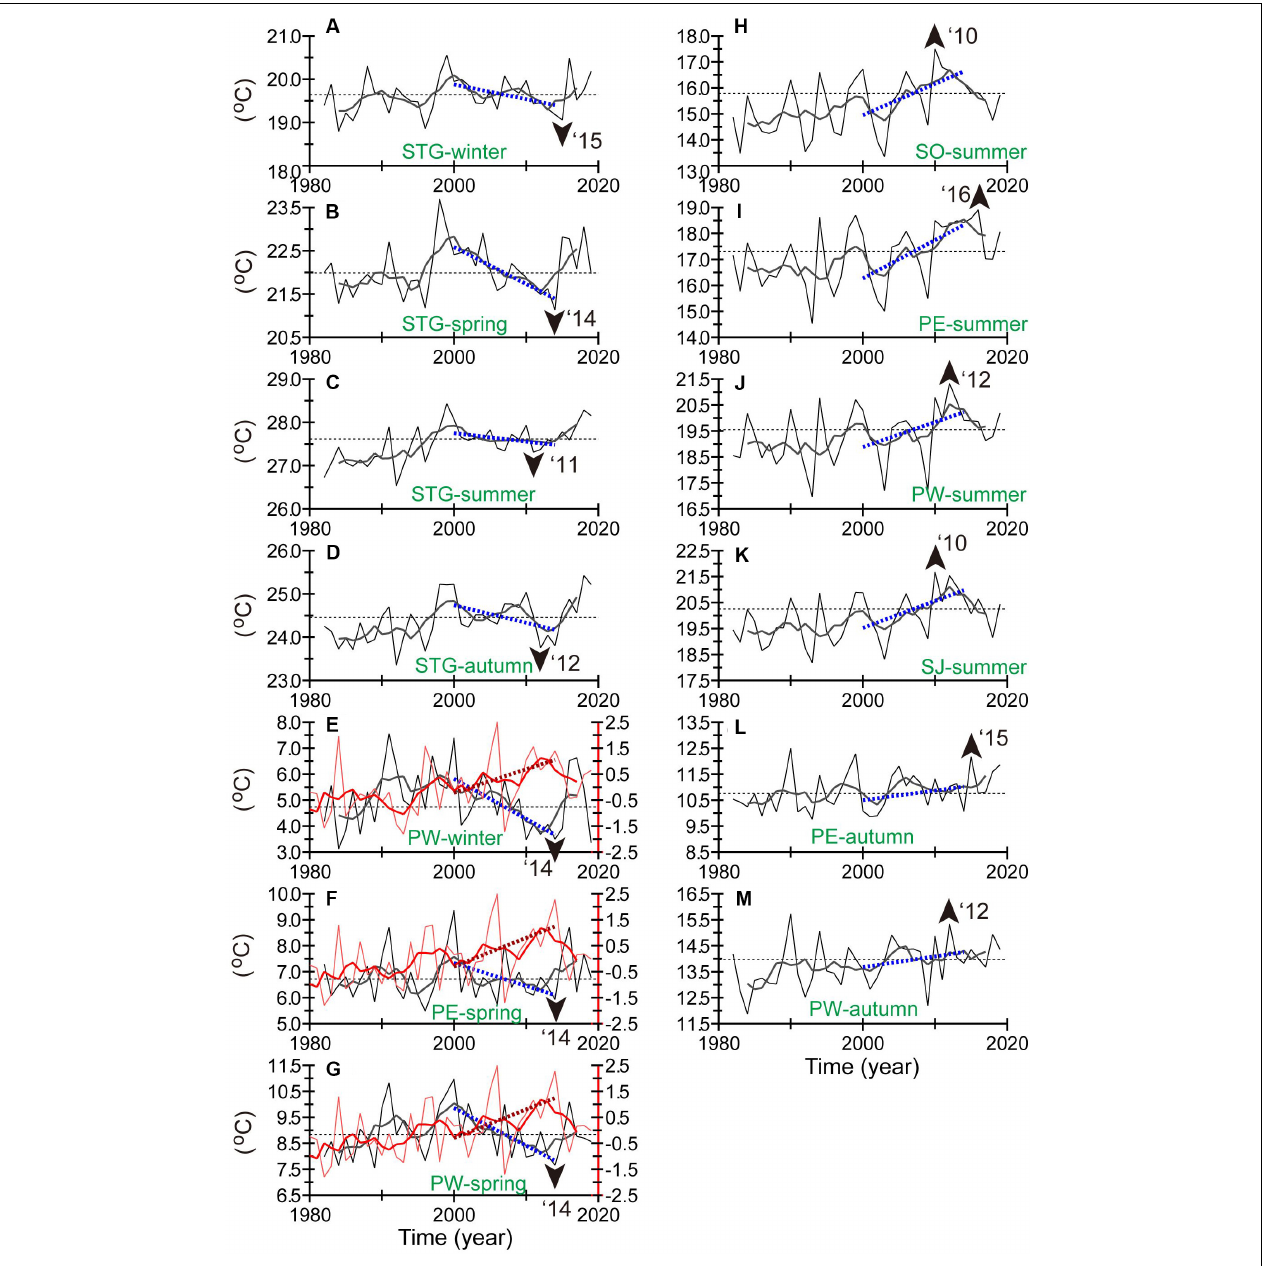
FIGURE 5 | The same as Figure 2 but for mean SSTs for each season and region (see Figure 4 for regions). Green labels in each panel represent “season” and “region.” For example, “STG-winter” in (A) means SSTs averaged for region STG in winter. The lowest and highest SSTs for 2010–2016 are indicated by arrowheads in (A–G) and (H–M) , respectively. In (E–G) , the integrated transport of Coastal Oyashio water across 46 ◦ N east of the Sakhalin coast based on normalized values was added as red lines along with the corresponding right axis. The integrated transport for winter (spring) was estimated by integrating from 1 October in the preceding year to 15 February (30